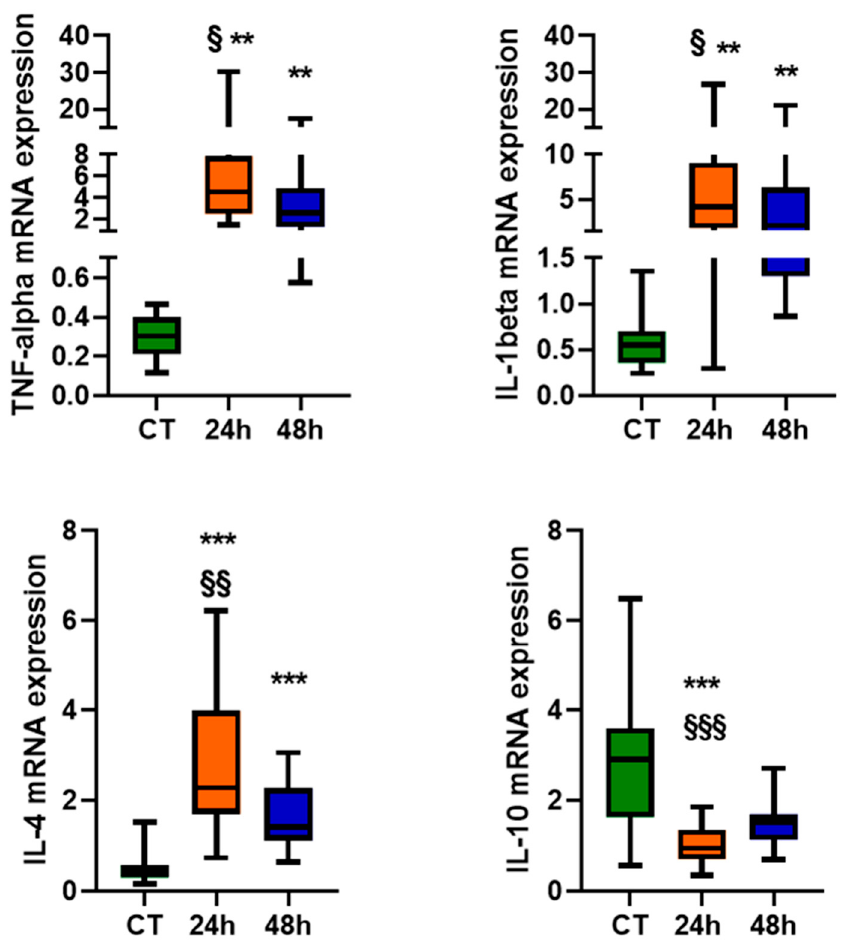
Figure 3. Cytokines’ mRNA levels, expressed as relative quantification (RQ) in the monocytes of healthy subjects (CT; n = 16) and patients 24 and 48 h after an ischemic stroke ( n = 24–26). Data are shown as the median and the minimum and maximum values. A Kruskal–Wallis test, followed by Dunn’s post-hoc test: ** p < 0.01 and *** p < 0.001 vs. CT; Wilcoxon’s signed-rank test: § p < 0.05, §§ p < 0.01, and §§§ p < 0.001 vs. 48 h.